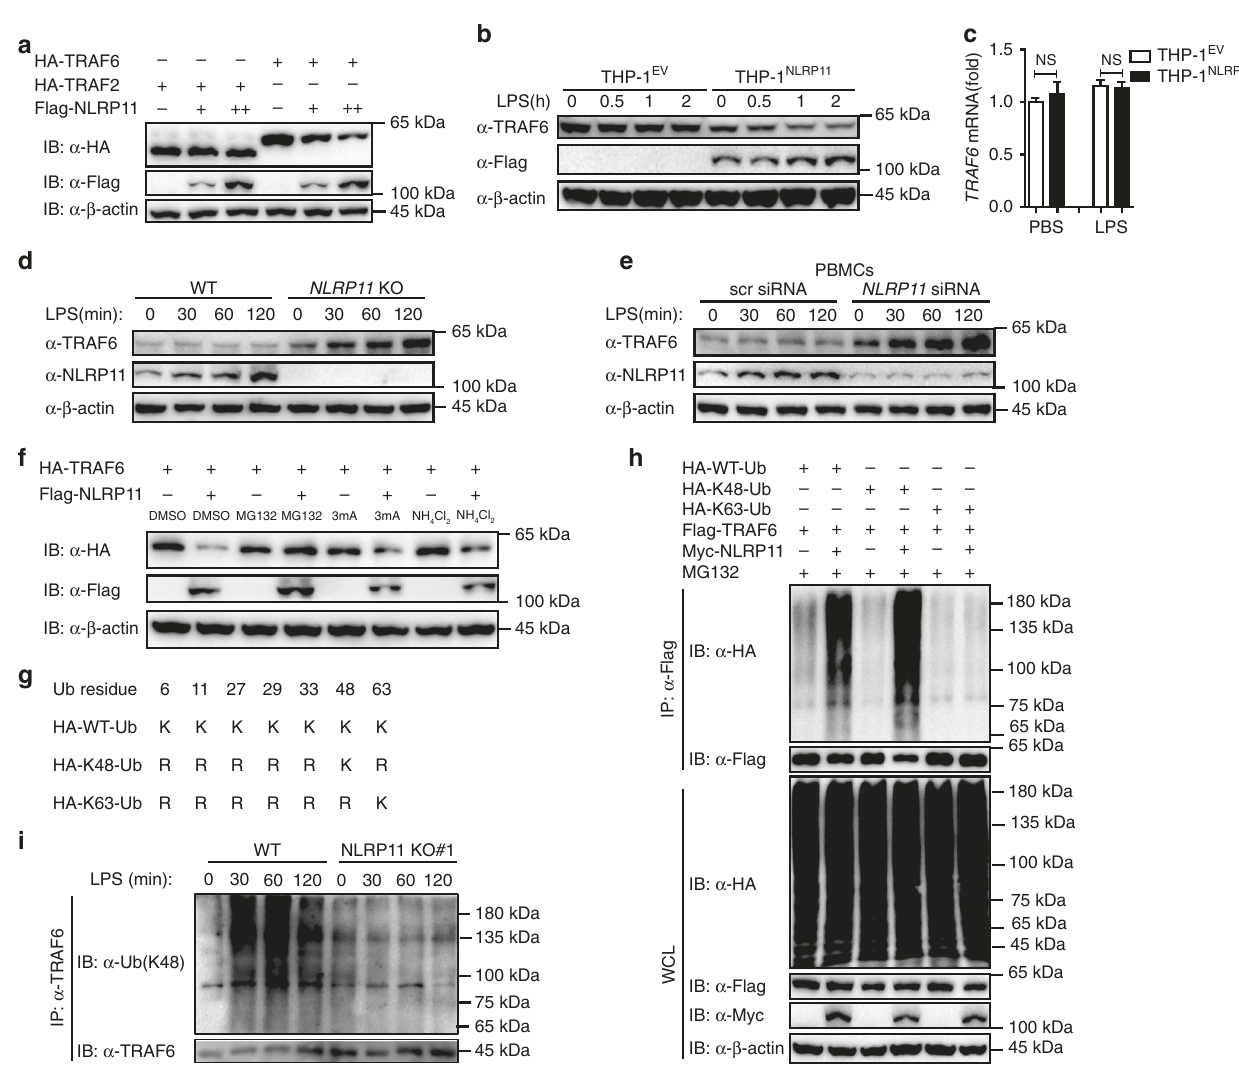
Fig. 5 NLRP11 promotes ubiquitination and degradation of TRAF6. a Immunoblot analysis of 293T cells transfected with HA-tagged TRAF6 or TRAF2 and the empty vector or increasing amounts of the vector encoding Flag-tagged NLRP11. b Immunoblot analysis of TRAF6 in WT THP-1 cells stably expressing the empty vector (THP-1 EV ) or Flag-tagged NLRP11 (THP-1 NLRP11 ), treated with LPS at different time points. c THP-1 cells as in b were incubated with or without LPS, and then total RNA was isolated to measure the transcription levels of TRAF6 by real-time PCR. d An immunoassay of endogenous TRAF6 in wild type (WT) or NLRP11 knockout (KO) THP-1 cells stimulated with LPS for the indicated periods. e PBMCs were transfected with NLRP11 -speci fi c siRNA or control siRNA for 48 h, and the cells were treated with LPS for the indicated periods and subjected to immunoblotting with the indicated antibodies. f Immunoblot analysis of extracts from 293T cells transfected with HA-TRAF6 and FLAG-NLRP11 or the control vector for 24 h, then treated for 6 h with 10 μ M MG132, 10 mM 3-MA, 20 mM NH 4 Cl, or DMSO. g A schematic diagram of ubiquitin and its mutants. h 293T cells were transfected with Flag-TRAF6 together with the empty vector or a vector encoding Myc-NLRP11 as well as with a vector encoding HA-WT-ubiquitin (Ub) or its mutants (HA-K48-Ub or HA-K63-Ub), and then treated with MG132 (10 μ M) for 6 h. WCLs were subjected to denaturing immunoprecipitation with anti-Flag beads and analyzed by immunoblotting with the indicated antibodies. i WT and NLRP11 KO THP-1 cells were stimulated with LPS for the indicated periods, and the K48-linked ubiquitination of endogenous TRAF6 was determined by immunoprecipitation with an anti-TRAF6 antibody and immunoblotting with the indicated antibodies. Data a , b and d – i are representative three individual experiments with similar results. Data c are presented as mean ± SEM of combined from three independent experiments with triplicate. NS, not signi fi cant. Signi fi cance was assessed using Student ’ s t